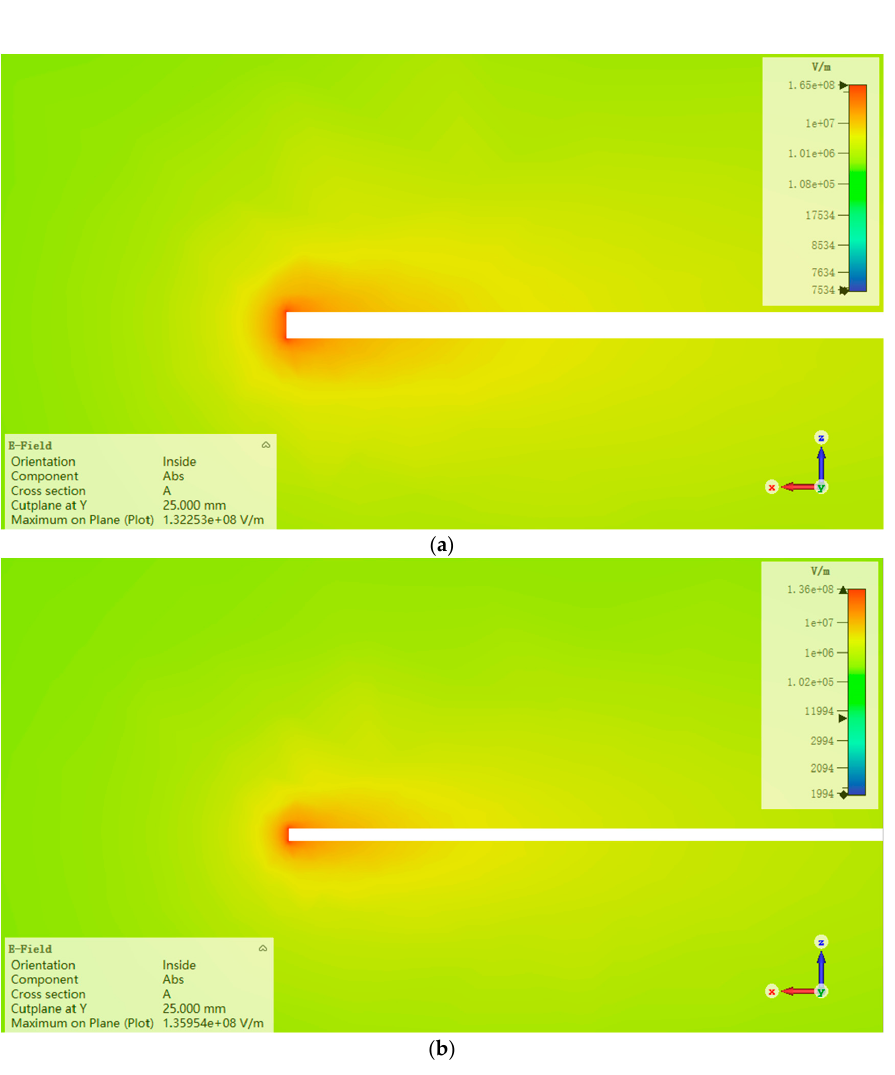
Figure 18. Simulation results of the electrostatic field intensity of the needle-plate electrodes. ( a ) The dielectric constant is 2.72; ( b ) the dielectric constant is 2.59.